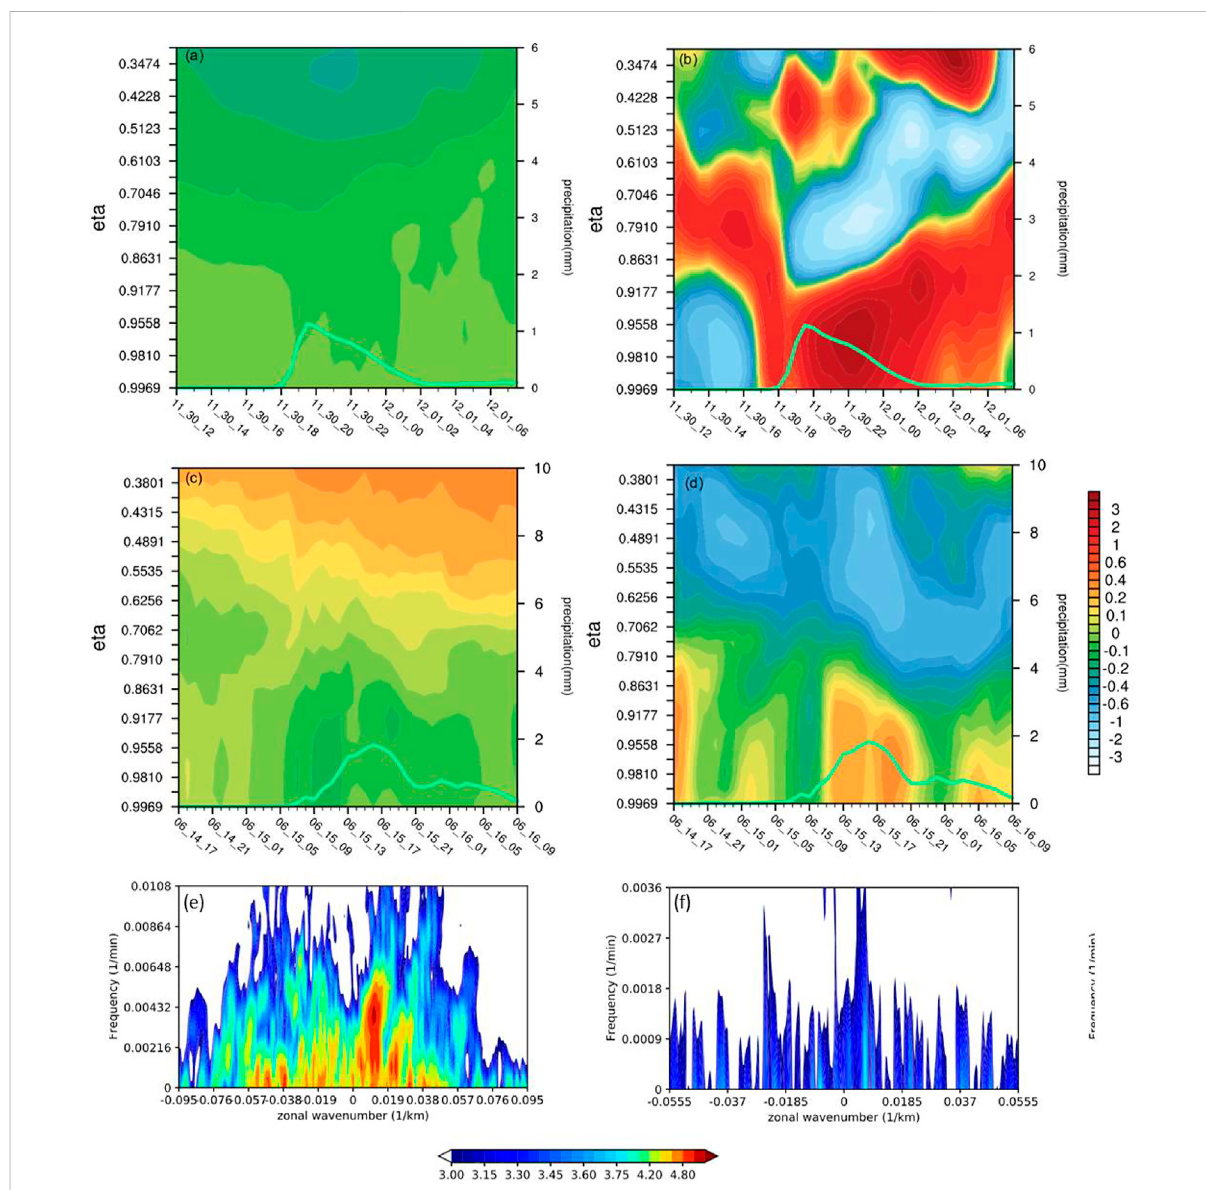
FIGURE 4 Domainaveragedmeridionalwindresidualbyusing (A) thesynopticmethod, (B) theBarnes fi lterinwintercase,zonalwindresidualbyusing (C) the synoptic method, and (D) the Barnes fi lter in summer case. The target domains are marked by blue and red rectangular regions in Figures 1F,H, respectively.Unitism s − 1 .Powerspectraldensityoftheverticalvelocityattheheightof12 km (E) along44.5 ° Ninthewintercase,and (F) 37.2 ° Ninthe summer case. Unit is m 2 · s − 2